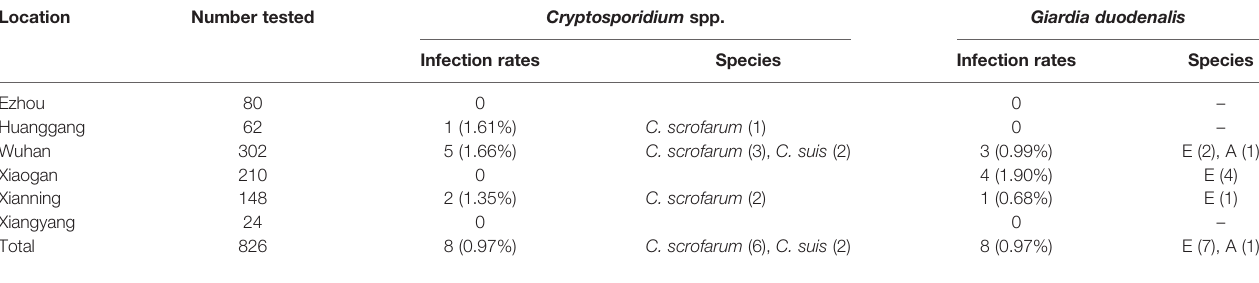
TABLE 1 | Prevalence and genetic characterizations of Cryptosporidium spp. and Giardia duodenalis arranged by sampled location in pigs in Hubei of China.